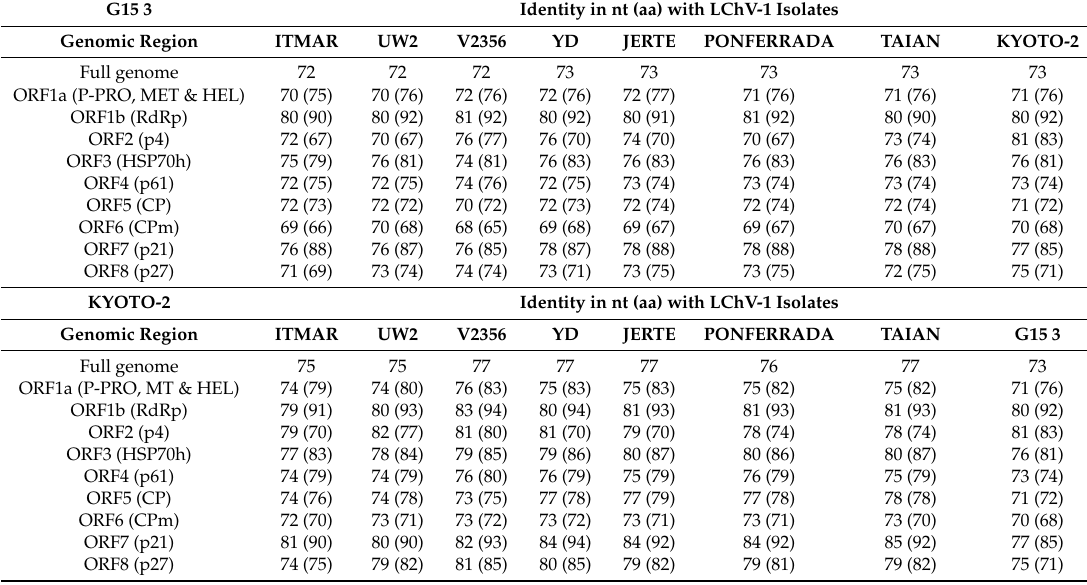
Table 2. Nucleotide and aminoacid identity percentages (%) between the G15 3 and Kyoto-2 isolates with all other fully sequenced LChV1